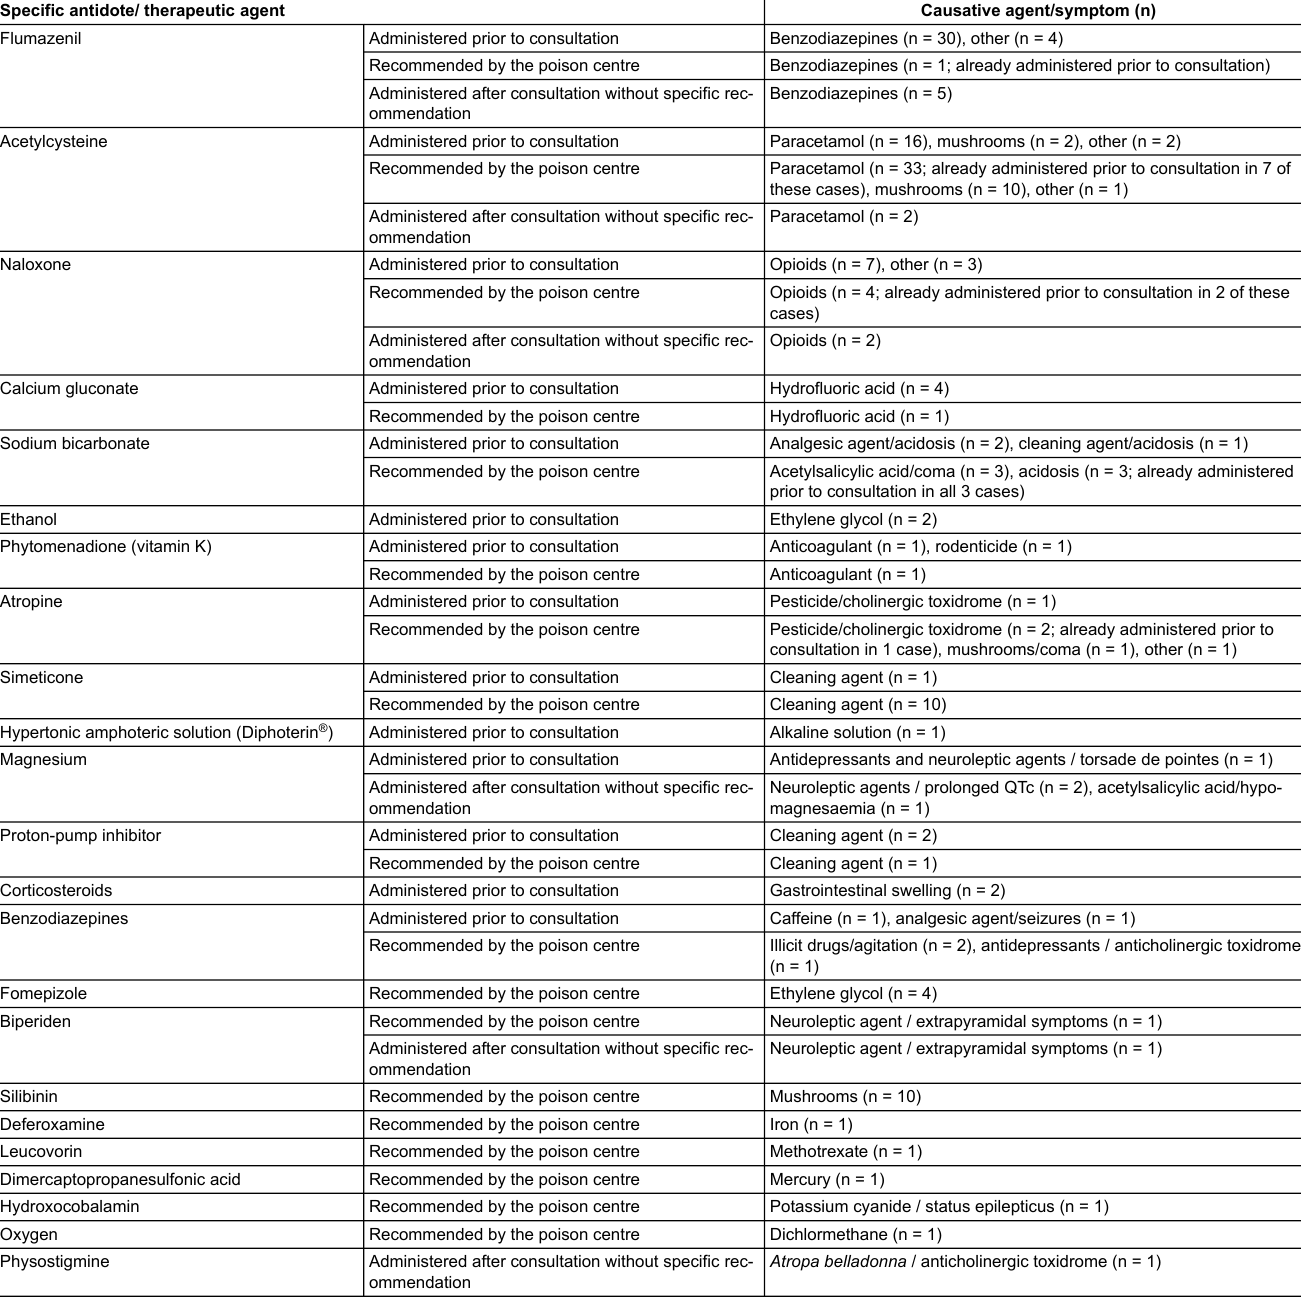
Table 4: Specific antidotes and therapeutic agents (left column) administered prior to consulting the poison centre, as well as those recommended by the poison centre or ad- ministered without specific recommendation after the consultation (right column: number of cases for causative agents/symptoms). Specific antidote/ therapeutic